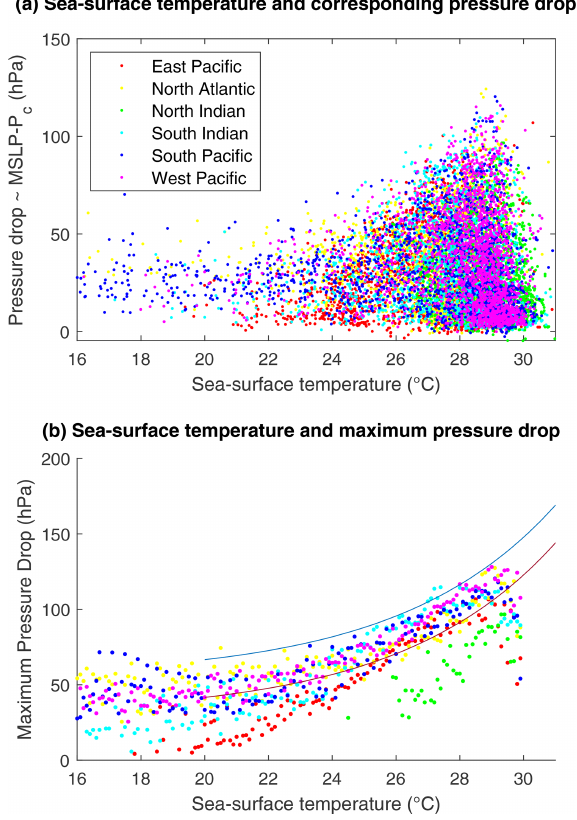
Figure 8. (a) Full distribution of observed pressure drop (hPa) val- ues for a given SST ( ◦ C). (b) Maximum observed pressure drop values for a given SST. The red line shows the least squares fit of Eq. (10), which corresponds to parameter values A = 30 . 6, B = 86 . 3 and C = 0 . 19. The blue curve is the capping function used to prevent unrealistic pressure drops, obtained by shifting the red curve